Question: What does this figure show? Answer in one sentence.
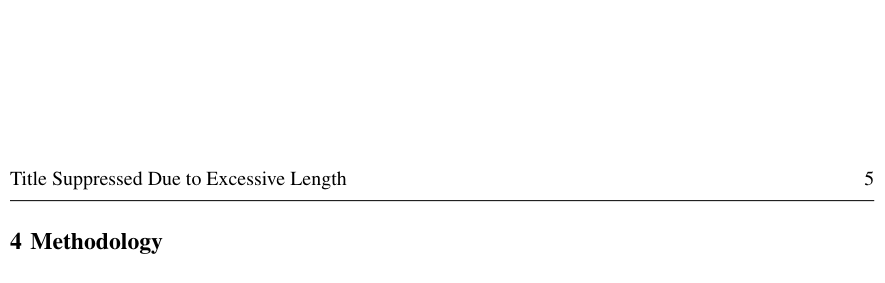
Answer: provides a block of the proposed solution. The proposed solution is composed of five components including data collection, pre-processing, classification of the tweets into relevant and irrelevant, location information extraction through NER, and topic modeling to automatically identify and extract the topics discussed in the relevant tweets. In the pre- processing step, we cleaned the dataset by removing less informative/unnecessary text, such as URLs, stop and short words, etc., For text classification, we proposed a merit-based late fusion framework incorporating the capabilities of several transformers-based NLP mod- els by assigning them weights based on their performance. Similarly, we employed several transformers-based NLP models in an NER framework for the identification and extraction of the location information from the text of the relevant tweets. For topic modeling, we rely on an open-sourced library namely BERTopic to identify hidden topics in the relevant tweets